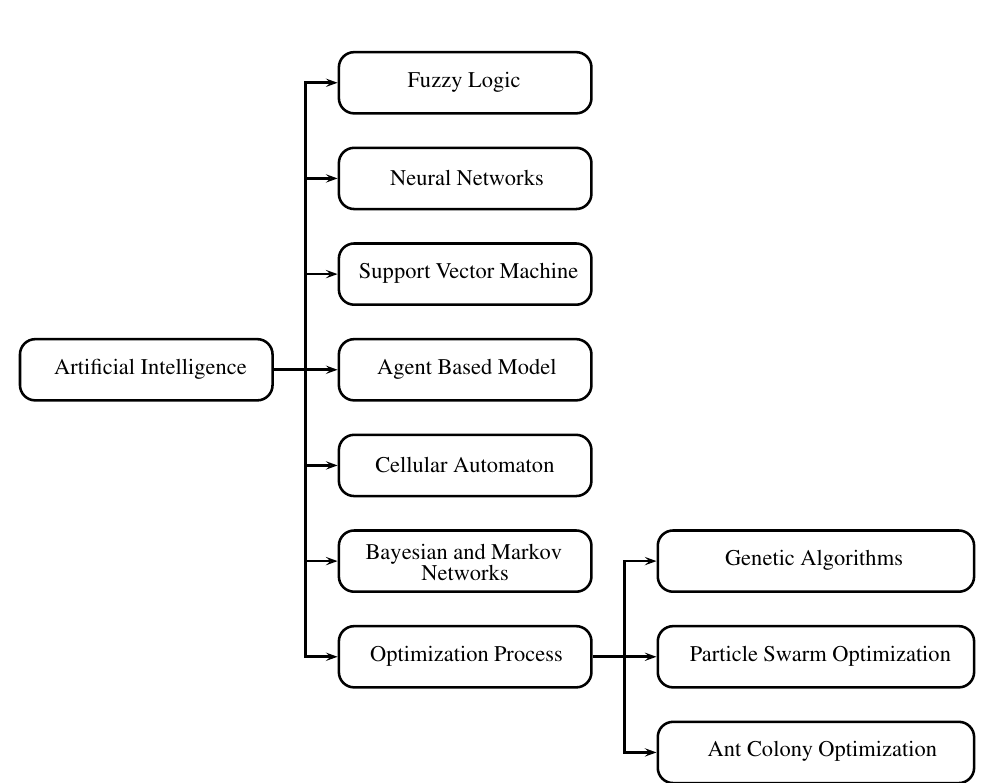
Figure 4. Artificial intelligence approaches according to a review of the applications on agricultural public